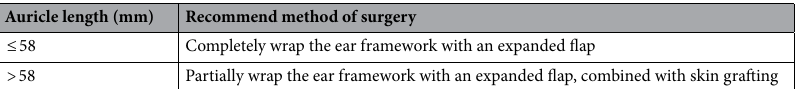
Table 3. Our experience-based guidelines regarding the use of the expanded flap in auricular